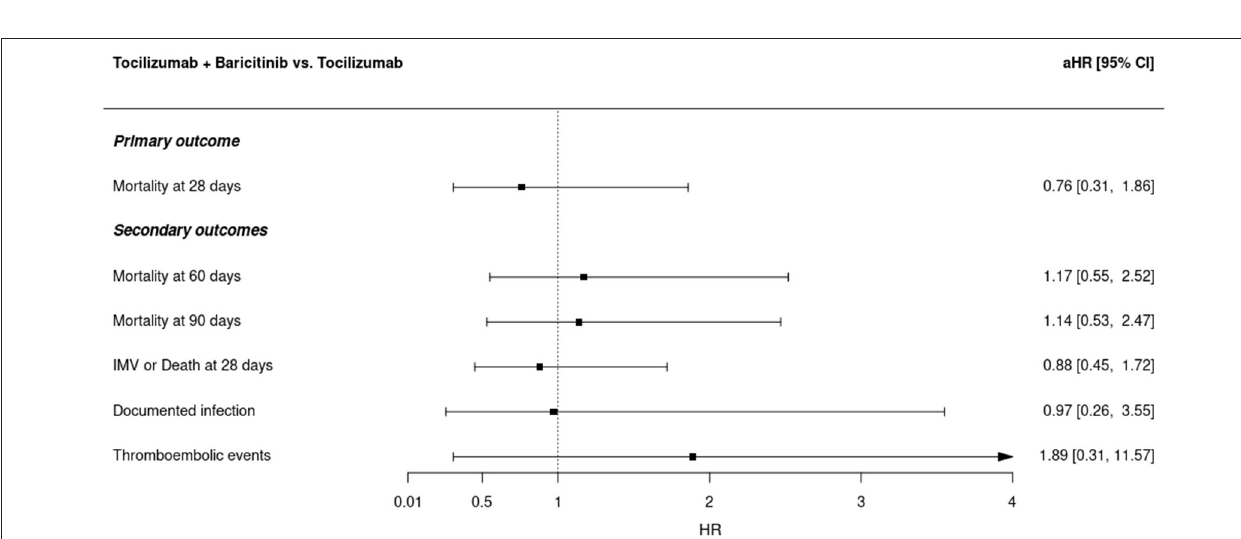
FIGURE 1 | Predictors for overall 28-day mortality in the multivariate Cox regression model in subjects receiving tocilizumab. aHR, adjusted hazard ratio; WHO, World Health Organization; FiO2, time-varying fraction of inspired oxygen.